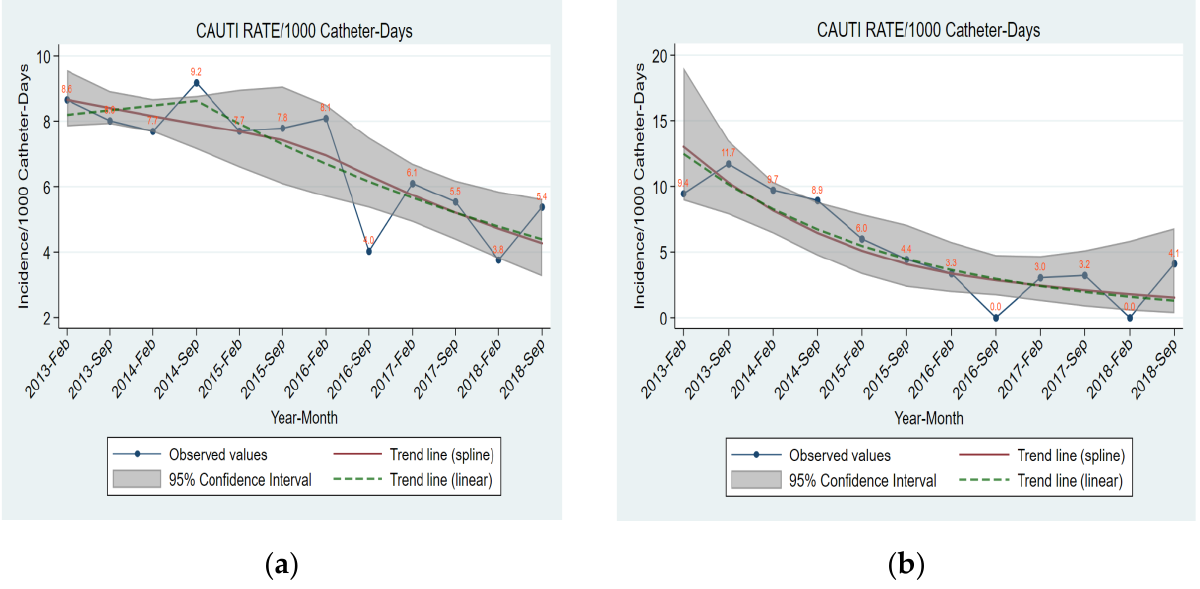
Figure 1. Observed values and estimated time trends for CAUTI rate in ( a ) total Hospital Clinics, ( b ) Adults Intensive Care Unit from January 2013 to December 2018.CAUTI: catheter-associated urinary tract infection; trends shown with dashed lines derived from Poisson regression models with robust standard errors, seasonality terms and linear or piecewise linear long term trend: log(N) = β 0 + β 1 t − + β 2 t + + β 3 × sin(2 π t/12) + β 4 × cos(2 π t/12) + β 5 × sin(4 π t/12) + β 6 × cos(4 π t/12) + log(ventilator-days) with N being the number of cases and t being time since study start in months (t − and t + piecewise linear time terms). Trends shown with grey area derived similarly but spline terms of time were used for long term trend instead of piecewise linear terms.